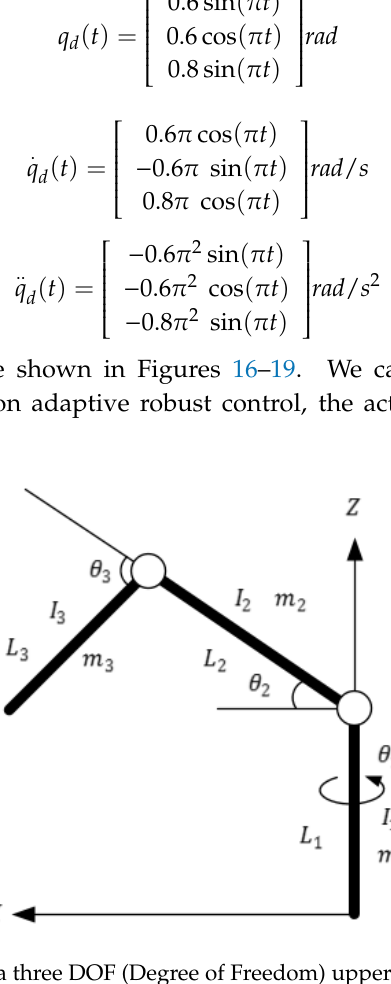
Figure 15. The sketch of a three DOF (Degree of Freedom) upper limb rehabilitation robot.